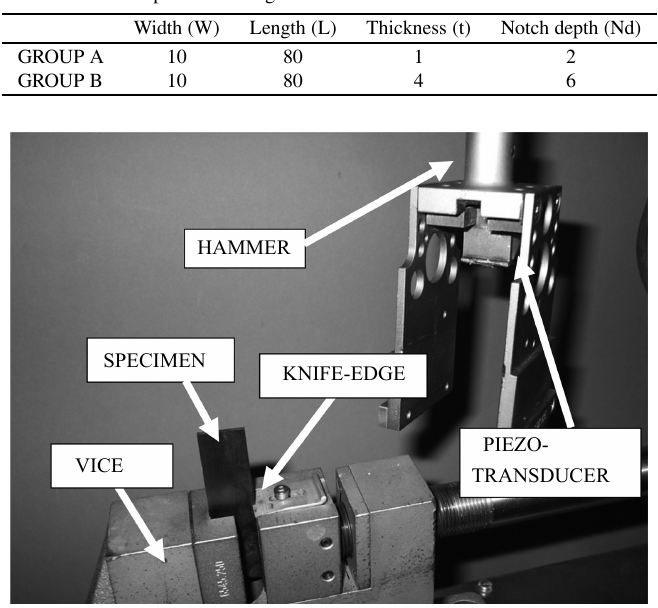
Fig. 2. Izod test con fi guration during